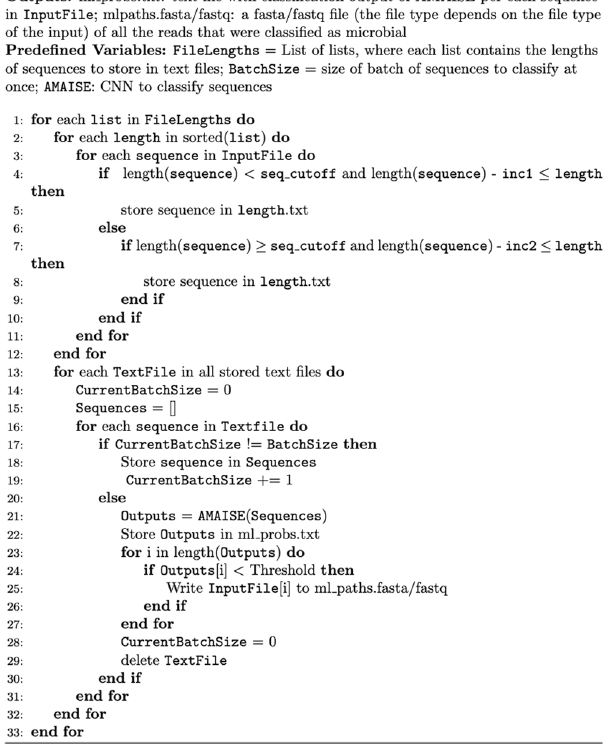
Fig. 8 Pseudocode describing Input preprocessing. To classify sequences in an input fi le, we fi rst sort the sequences ef fi ciently by binning the sequences by length and storing sequences of similar length in a single text fi le. We then classify the sequences in each text fi le using AMAISE. We input the sequences to AMAISE in batches and delete a text fi le after classifying all the sequences in